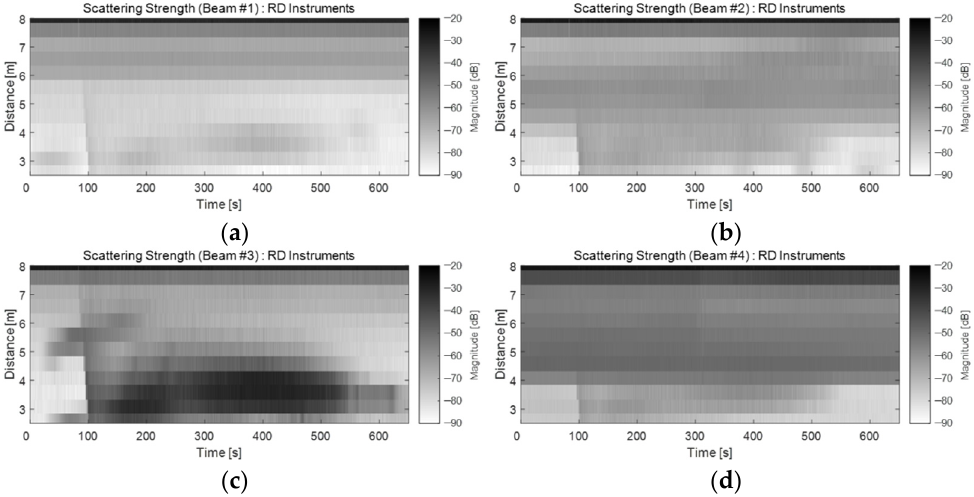
Figure 2. Backscattering strength S v derived from the method provided by RD Instruments: beams ( a ) #1, ( b ) #2, ( c ) #3, and ( d ) #4 of the ADCP.